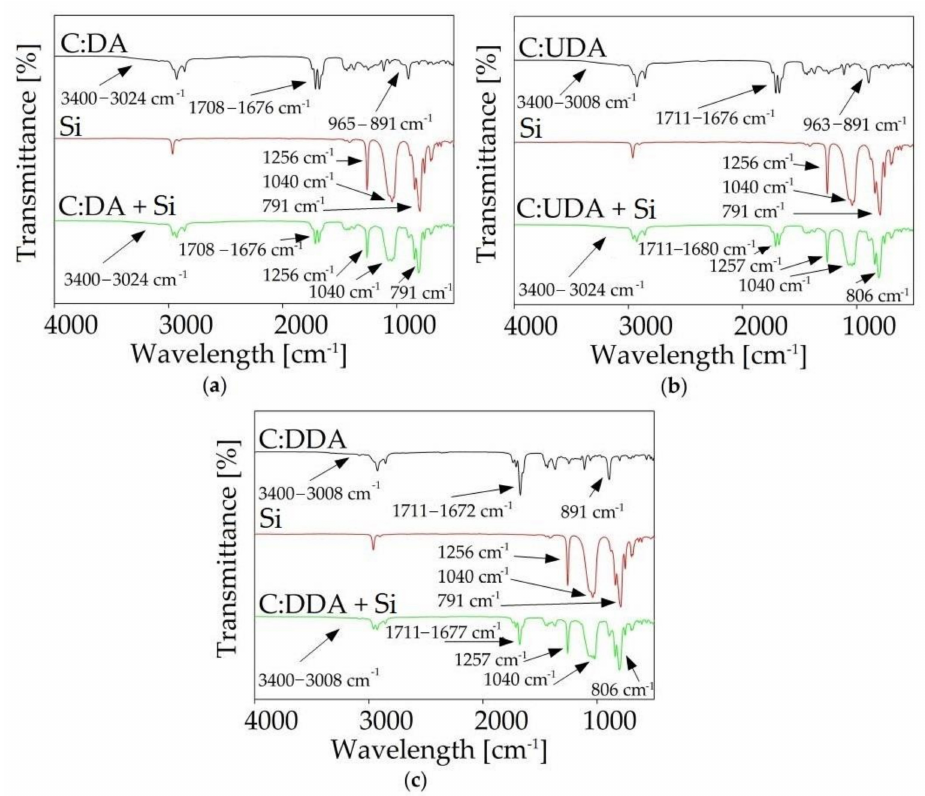
Figure 13. FT-IR spectra before and after siloxanes’ (S) absorption for ( a ) C:DA (1:1), ( b ) C:UDA (1:1) and ( c ) C:DDA